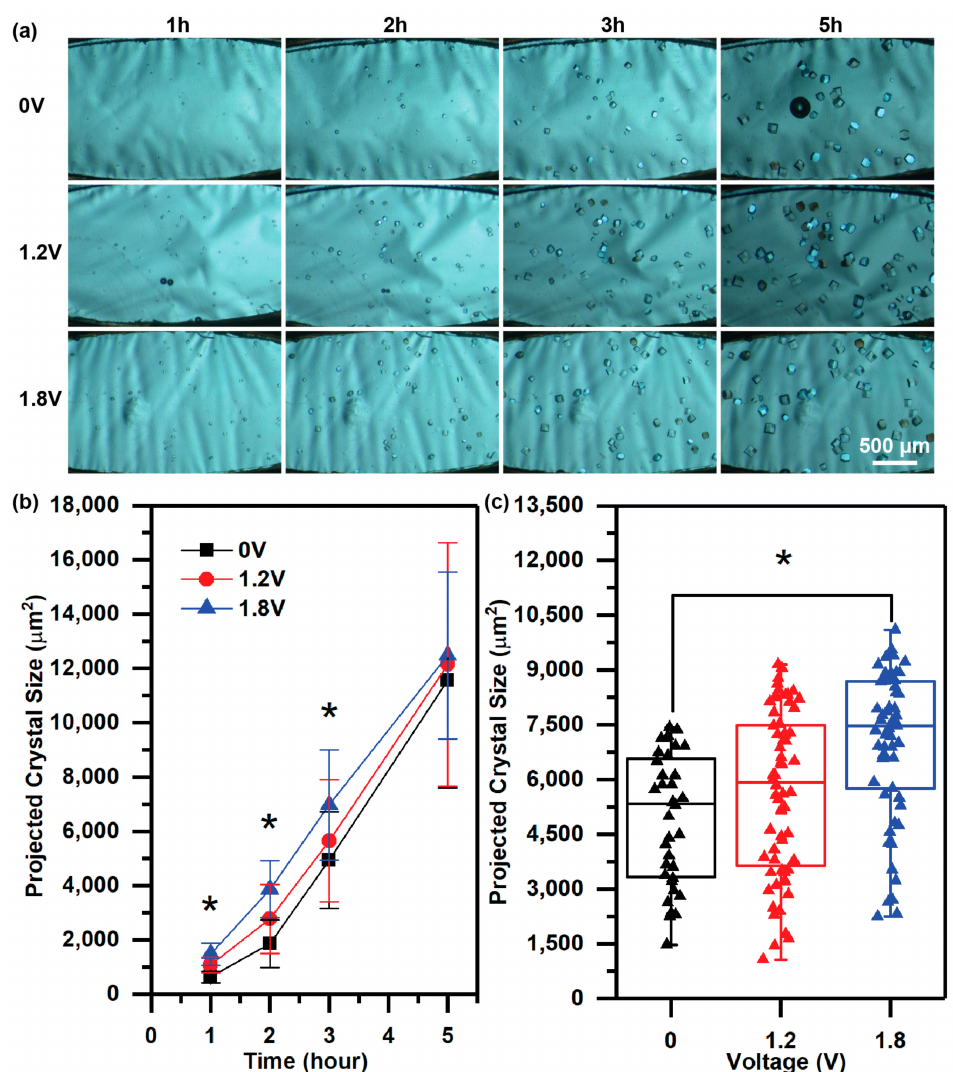
Figure 5. ( a ) Optical micrographs under cross-polarized light showing the time evolution of hen egg-white lysozyme (HEWL) crystal nucleation and growth with the application of 0 V, 1.2 V, and 1.8 V in a microfluidic device. ( b ) A plot of the average crystal size as a function of time from the images in ( a ). Error bars represent the standard deviation. ( c ) A box and whiskers plot of the crystal size distribution at 3 h with the application of voltages at 0 V, 1.2 V, and 1.8 V. The middle line shows the median, and the ends of the box indicate the upper and lower quartiles. * Crystals prepared at 1.8 V at 1 h, 2 h, and 3 h were statistically larger than those prepared at 0 V, ANOVA p <